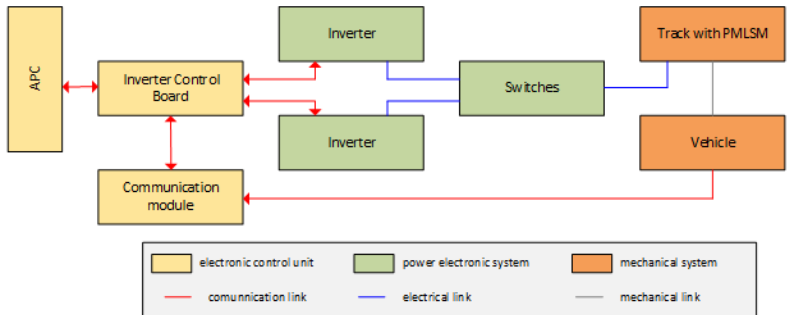
Figure 11. Drive system topology with a dual 3-level inverter set.